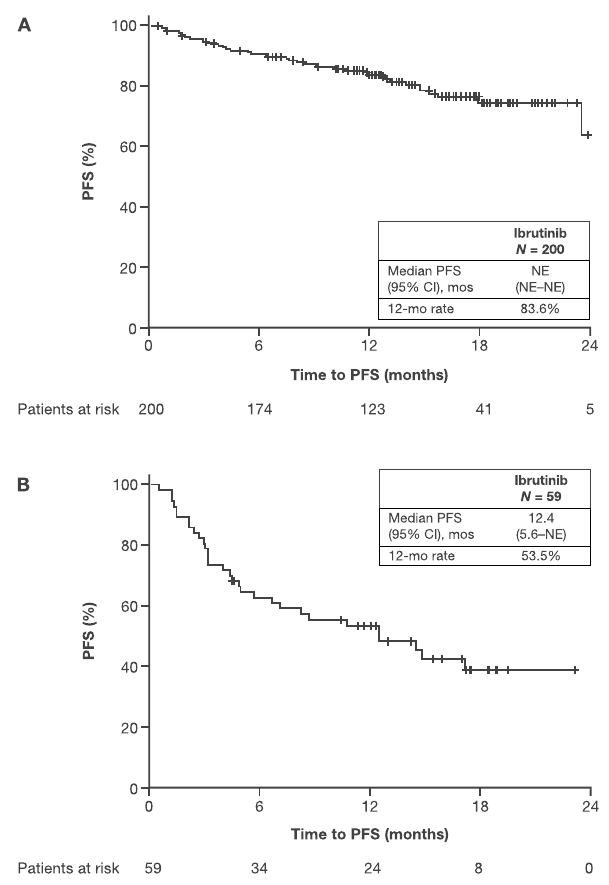
Fig. 1 Impact of ibrutinib on PFS in patients with CLL/SLL ( A ) and patients with MCL ( B ). CI confidence interval; CLL chronic lympho- cytic leukemia; MCL mantle cell lymphoma; mo month; NE not esti- mable; PFS progression-free survival; SLL small lymphocytic lym-